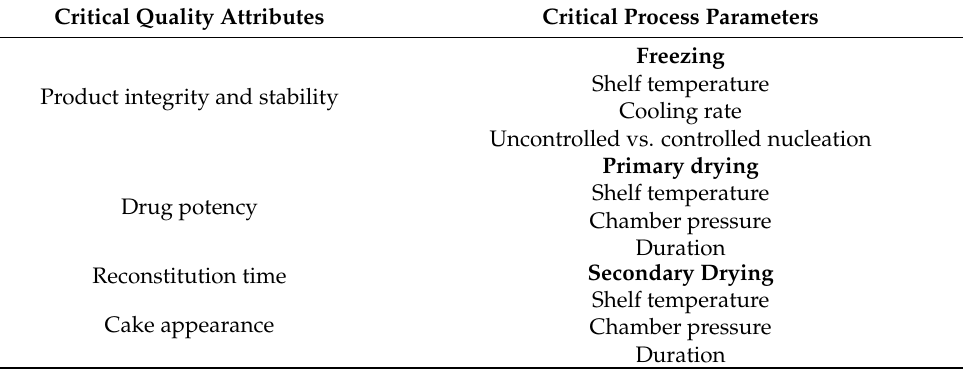
Table 1. Critical quality attributes and process parameters in lyophilization